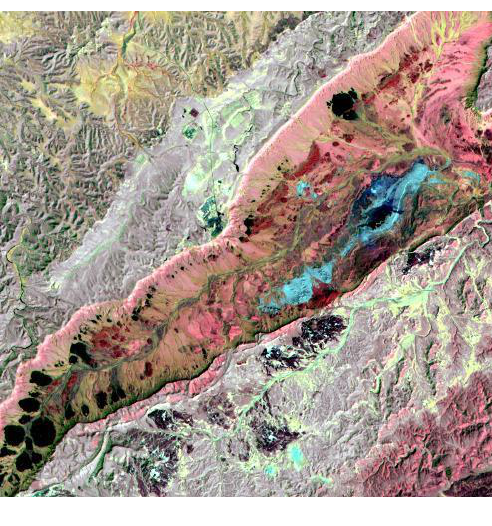
Figure 3. False coloured RGB image [band 12–479 nm (blue), 65–801 nm (green) and 213–2201 nm (red)] of the ‘Makhtesh Ramon’ study region as a simulated EnMAP